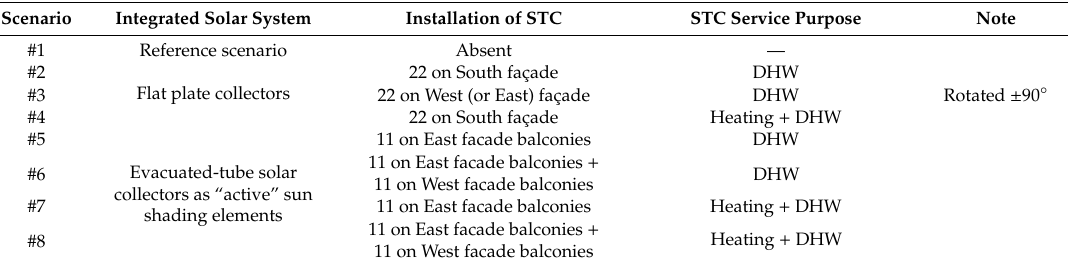
Table 2. Investigated integration